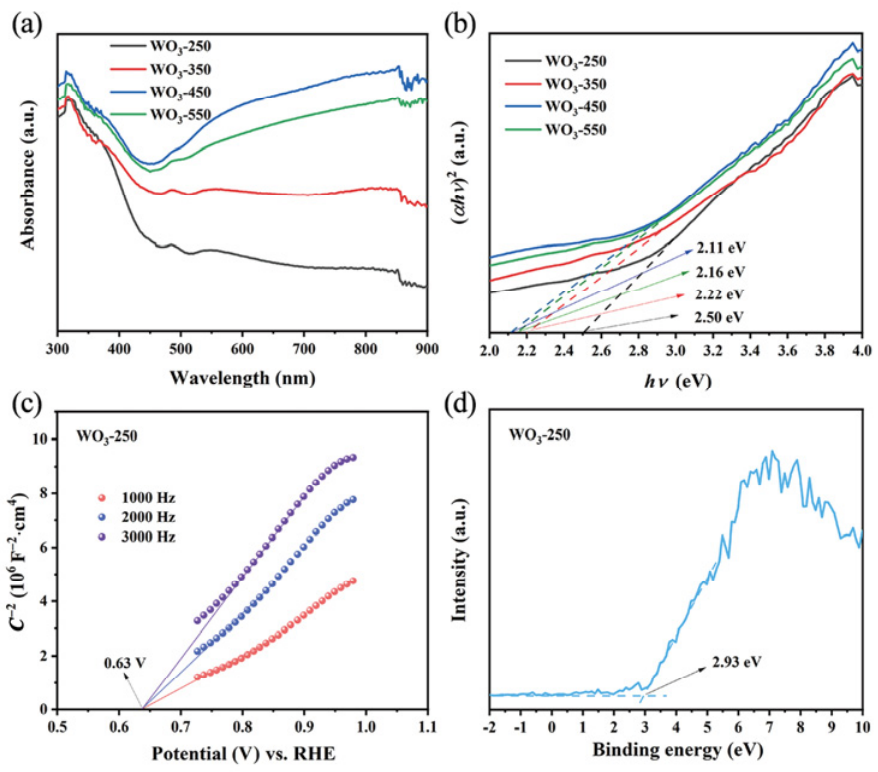
Fig. 7 (a) UV–Vis absorption spectra and (b) corresponding optical band gaps (where α in the Y -axis title represents the absorbance, h represents the Planck constant, and υ represents the frequency); (c) M–S plot and (d) VB spectrum of WO 3